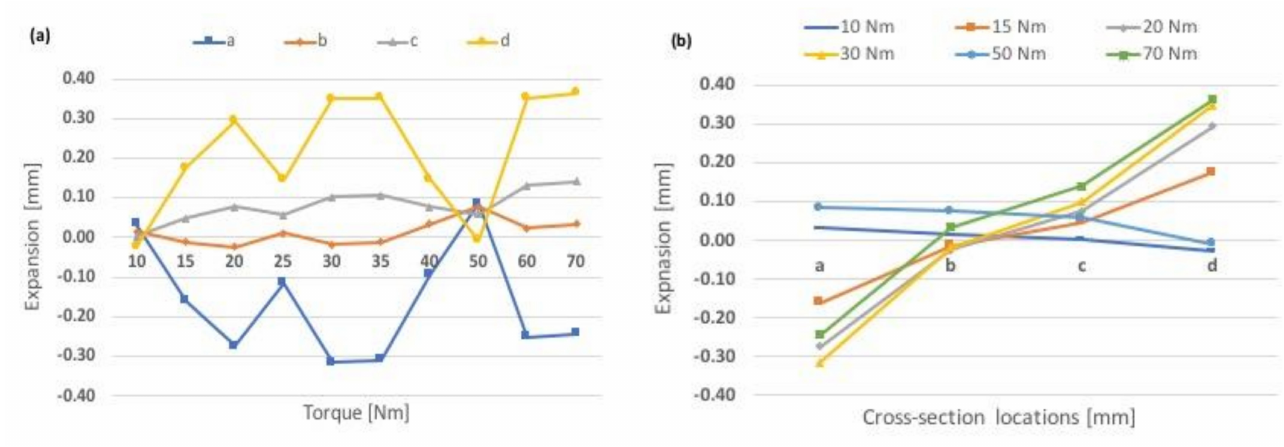
Figure 9. Test 1a—Ring deformations of lubricated bearing ring on single sleeve: ( a ) expansion as a function of torque and ( b ) expansion at different cross-section locations.